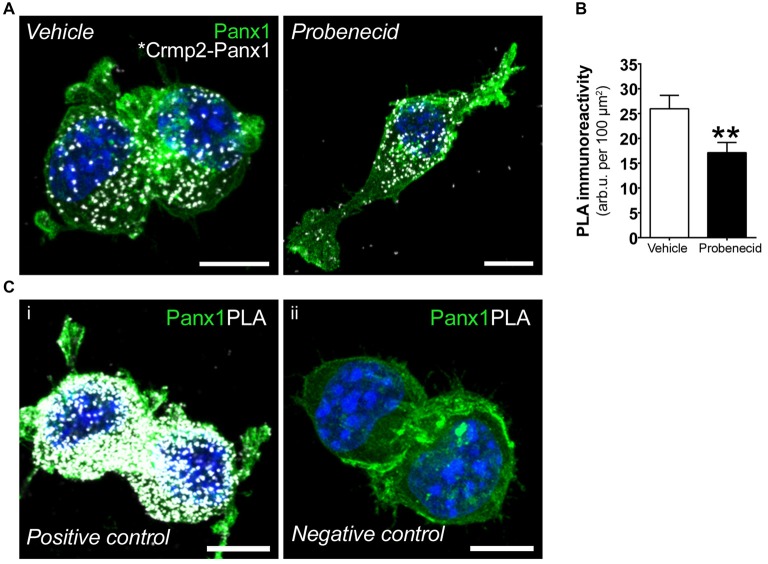
Probenecid decreases proximity ligation assay (PLA) between Panx1EGFP and Crmp2. (A) Representative confocal maximum intensity projections of vehicle- (left) and probenecid-treated (right) Panx1-EGFP-expressing N2a cells demonstrating PLA-positive Crmp2-Panx1 clusters (white). (B) Probenecid treatment significantly decreased mean fluorescence intensity of the PLA signal (vehicle: 26.0 ± 2.7 arb.u. per 100 μm2 vs. probenecid: 17.1 ± 2.1 arb.u. per 100 μm2, p = 0.0037, n = 77 cells and n = 70 cells, respectively, Mann-Whitney test). (C) Controls for PLA included (i) cells were incubated with α-GFP anti-mouse and α-GFP anti-rabbit to serve as a positive control. (ii) No primary antibodies were included to serve as a negative control. Hoechst 33342 was used as a nuclear counterstain. Scale bars, 10 μm.